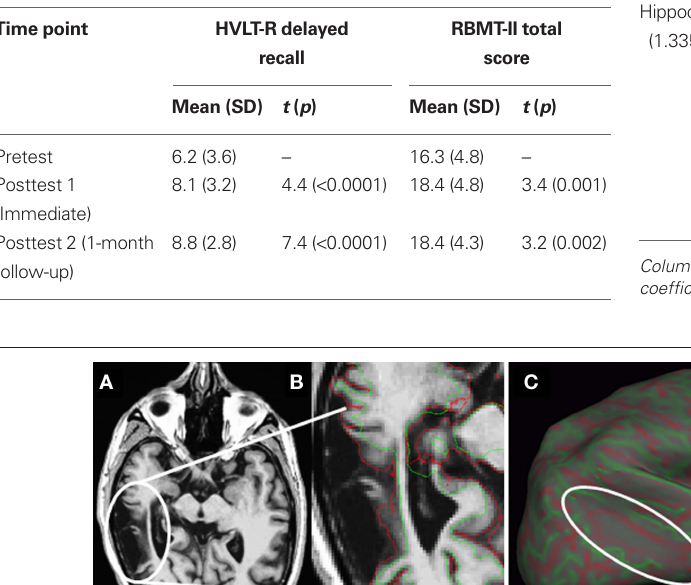
Table 3 | outcome scores for TBI participants ( n = 50) measured at three time points, with statistical comparisons against pretest scores.